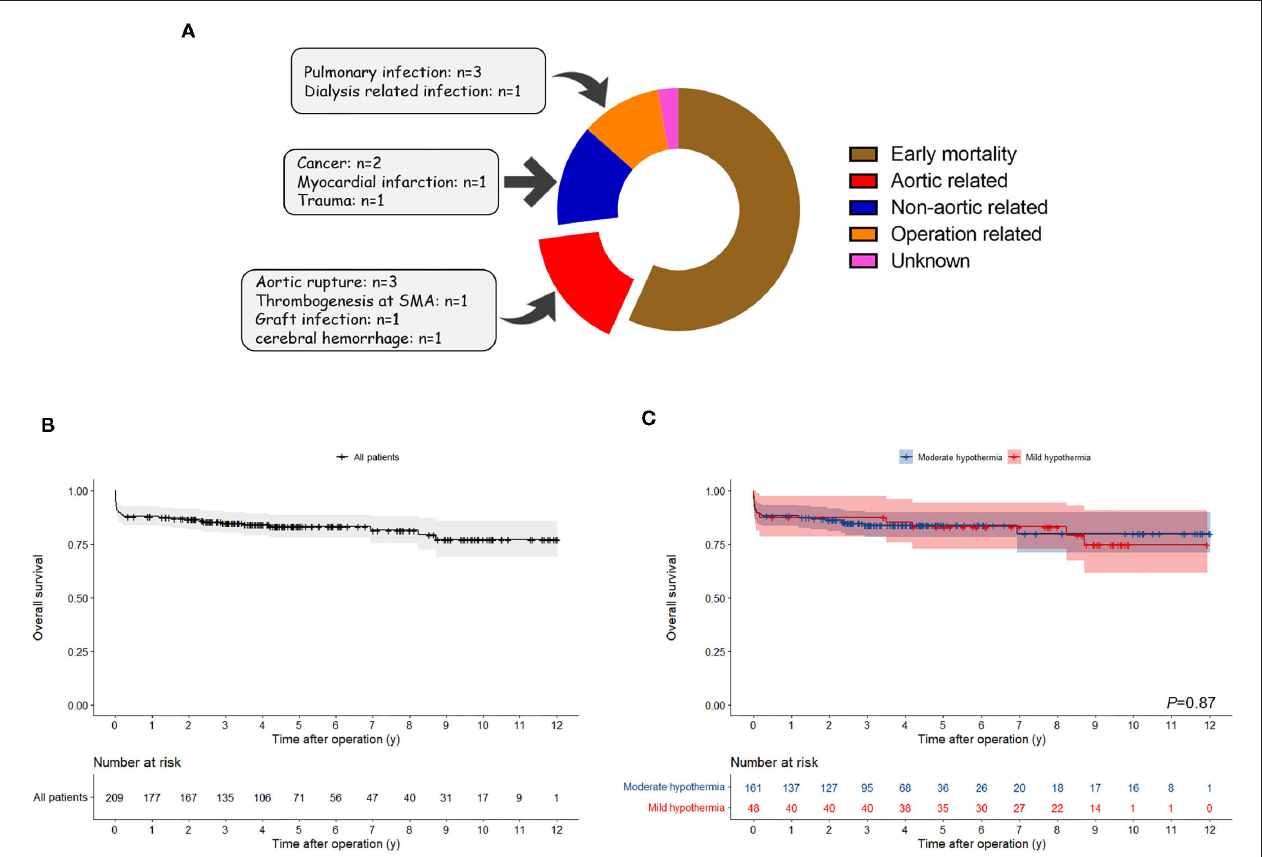
FIGURE 3 | Overall survival analysis. (A) The cause of death during follow-up. Late death occurred at 16 patients and 6 of them were aortic related. (B) Kaplan–Meier survival curves for overall survival in all patients. (C) Kaplan–Meier survival curves for overall survival in the mild and moderate hypothermia group and log-rank test indicated that significant difference was not observed between two groups.